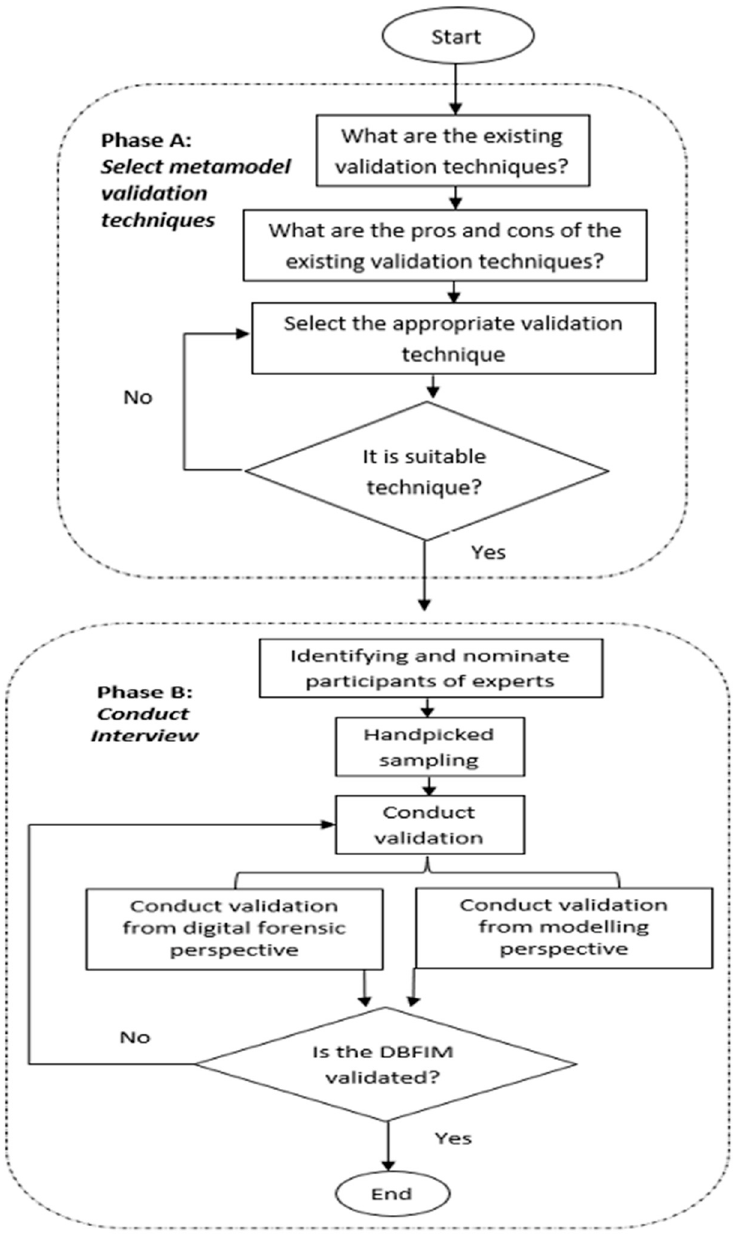
Figure 5. Metamodel validation